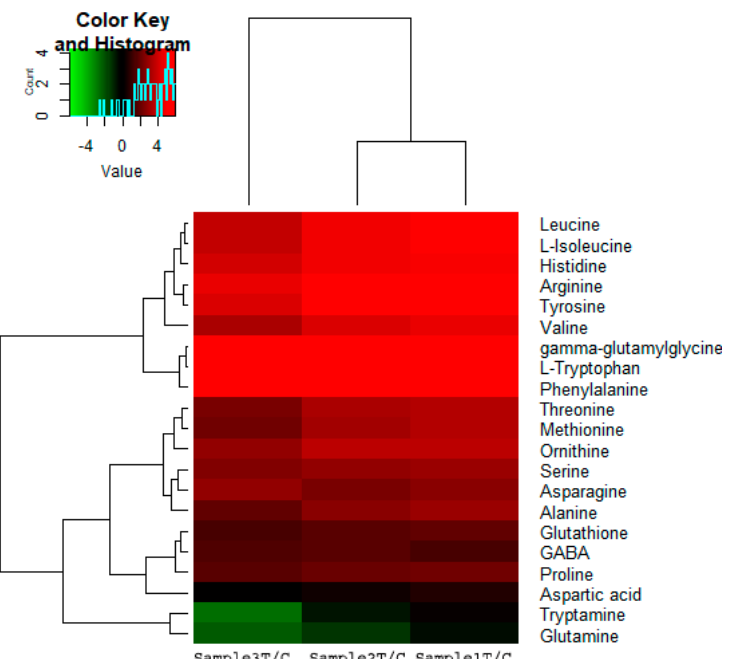
Figure 3. Changes in amino acid levels in the context of amino acid biosynthesis pathways in date palm leaves under UV ‐ B irradiation. Metabolites detected shown in red color, solid lines represent one ‐ step reactions, and dashed lines represent multi ‐ step reactions.